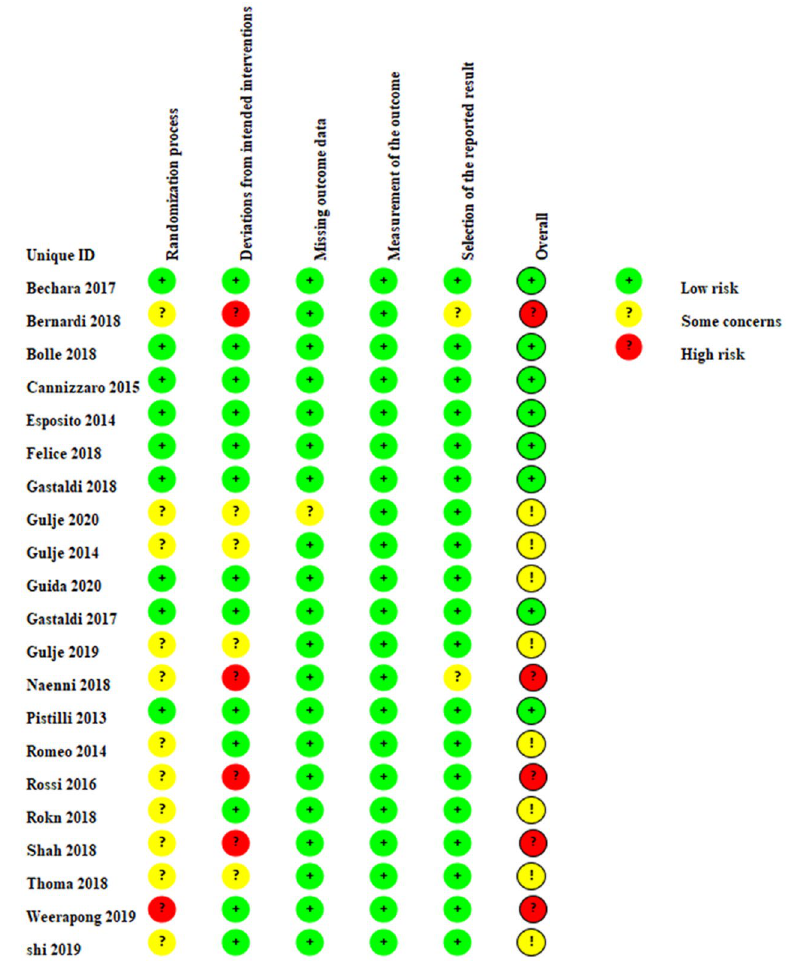
Table 2. Quality assessment of included studies by ROB 2. Generated by RevMan Web, https:// revman. cochr ane.